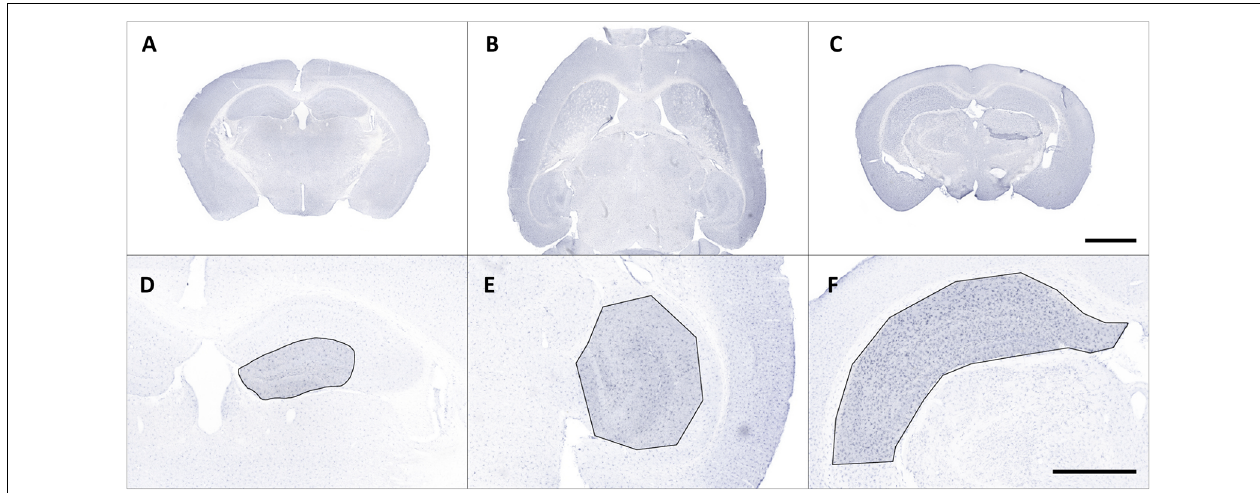
FIGURE 1 | Representative overview photomicrographs showing Iba1 staining in coronal (A,C) and horizontal (B) brain sections of male C57BL/6J mice (A) db/+ mice (B) and C57BL/6J mice with ischemia (C) . Exemplary regions of interest (ROIs) were manually selected in corresponding images (D–F) . Scale bars represent 2,000 µ m (A–C) and 1,000 µ m (D,E)